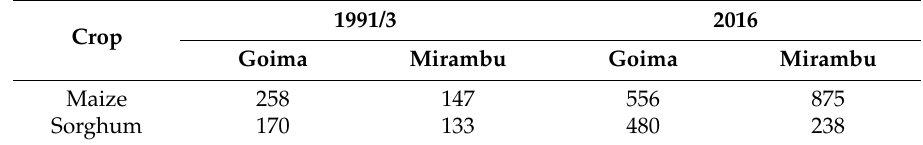
Table 5. Yield per acre (kg) of different staple crops in the two study sites. Crop